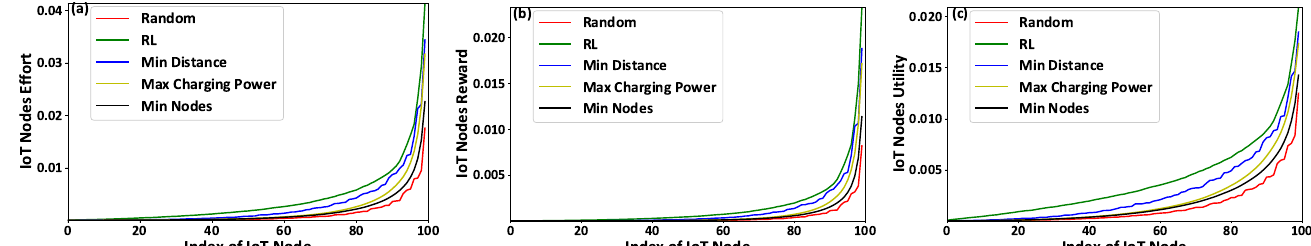
Figure 6. ( a ) IoT nodes’ invested effort, ( b ) gained reward, and ( c ) achieved utility — A Comparative